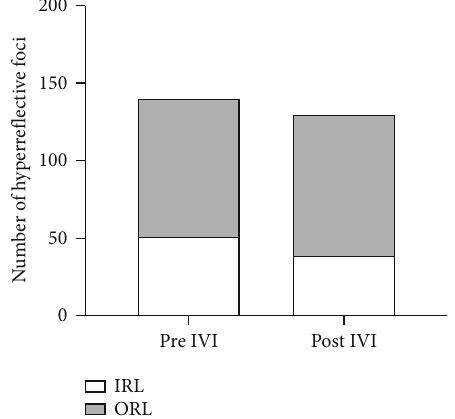
Figure 5: Bar graph representing changes in the distribution of hyperre fl ective foci (HF) in patients with diabetic macular edema (DME) treated with anti-VEGF or dexamethasone implant. Figure shows the di ff erence in the distribution of in HF between the inner retinal layers (IRL, from the ILM to inner nuclear layer, INL) and the outer retinal layers (ORL, from the outer plexiform layer, OPL to the retinal pigment epithelium, RPE) at baseline compared to 30 days after the